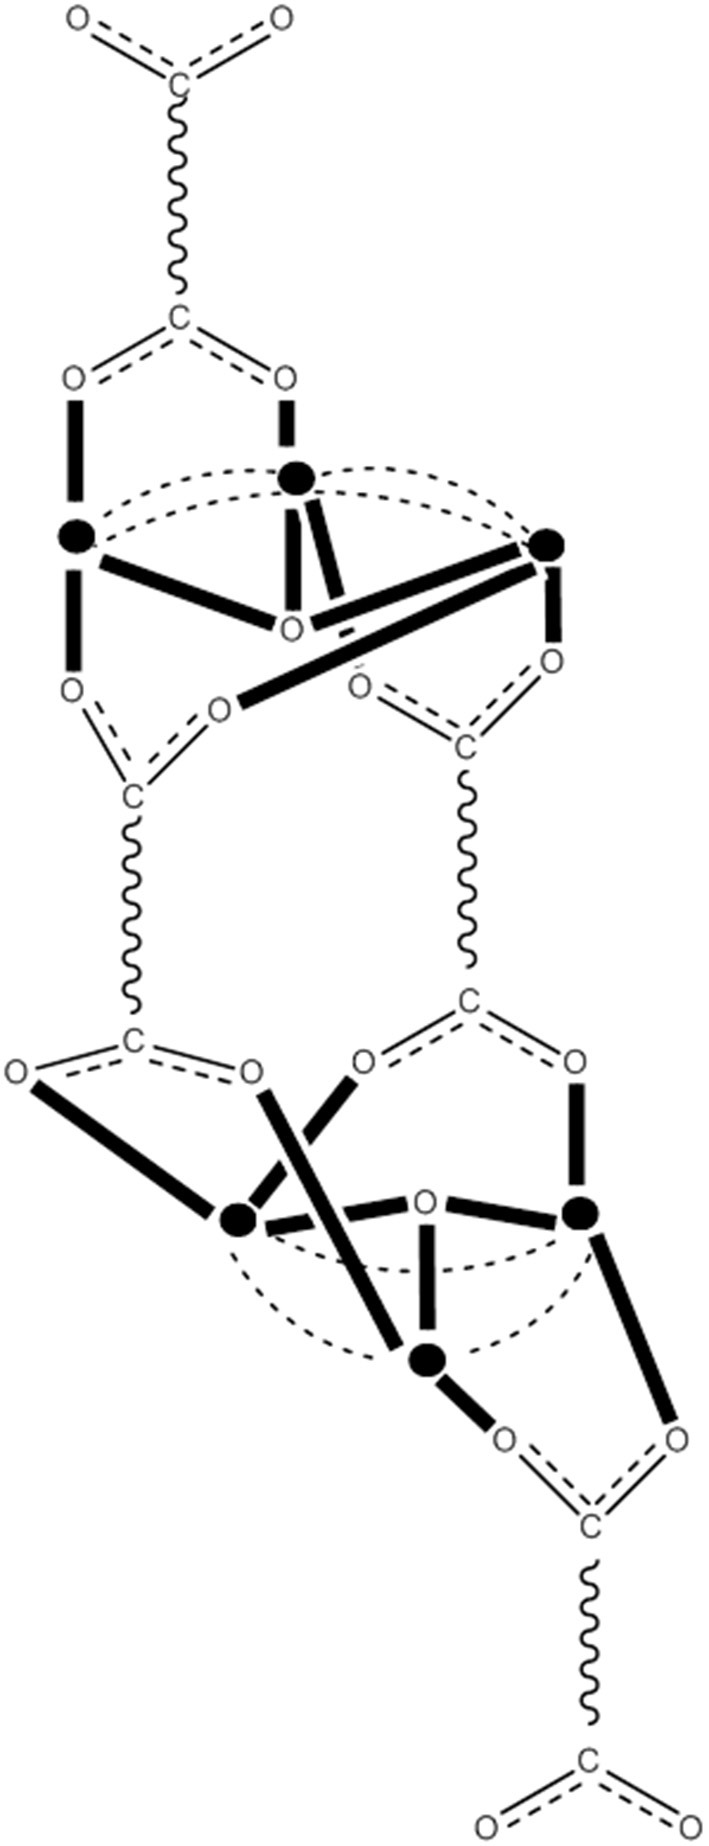
An extended view of the core of cluster 56. The symbol  represents MnIII. The dashed curve represents the diatomic oximato groups of mpko−. The line  represents the aromatic and aliphatic backbone of the atx2− ligands. Coordination bonds are drawn in bold (Schematic drawing inspired by Mowson et al., 2013).